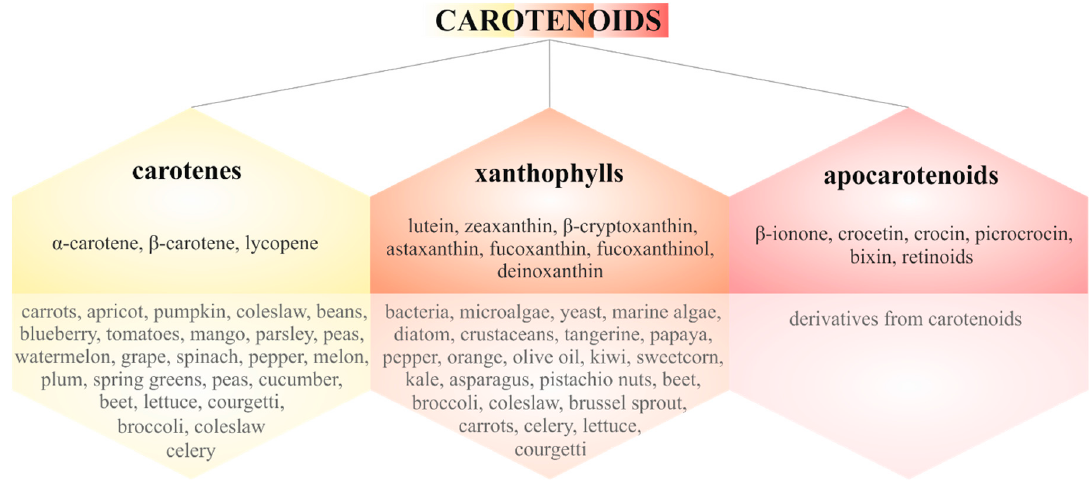
Figure 2. Classification of carotenoids with major representatives and their sources.